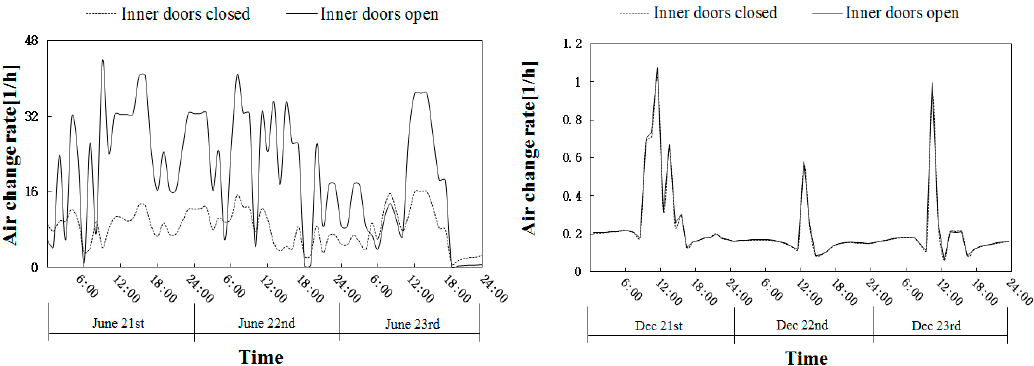
Figure 3. Hourly average air exchange rate of the building in summer and in winter.